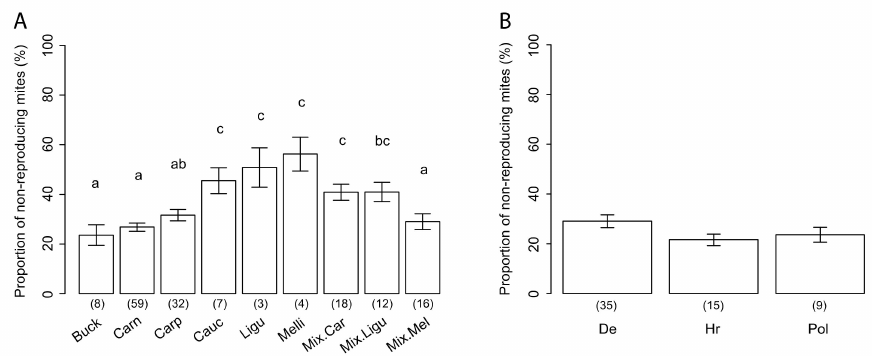
Figure 4. Variation of the SMR score according to the honey bee genotype. ( A ) Scores in the nine di ff erent genotypes. ( B ) Scores in the A. m. carnica genotype, sampled in three di ff erent countries. n-values are indicated below each bar. Di ff erent letters indicate significant di ff erences between groups. Buck, Buckfast; Carn, Carnica; Carp, Carpatica; Cauc, Caucasica; Ligu, Ligustica; Melli, Mellifera; mix, hybrid; De, Germany; Hr, Croatia; Pol, Poland.